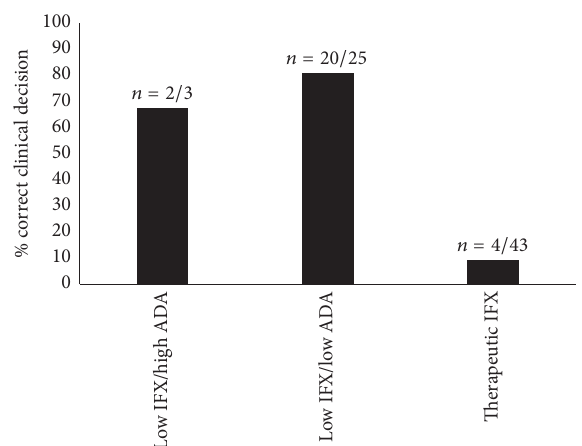
Figure 2: Correct clinical decision by group following infliximab therapeuticdrugmonitoringininflammatoryboweldiseasepatients with concerns for loss of response.